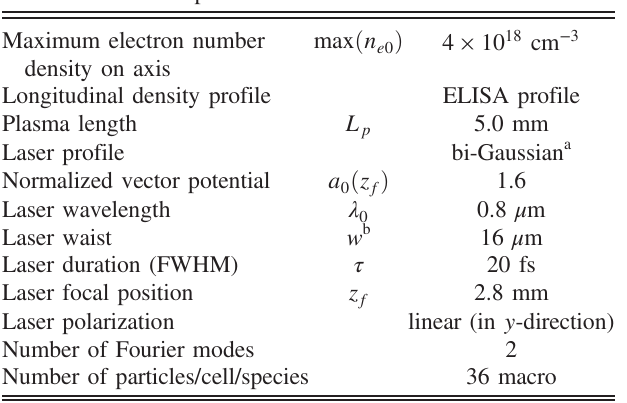
TABLE I. List of parameters.